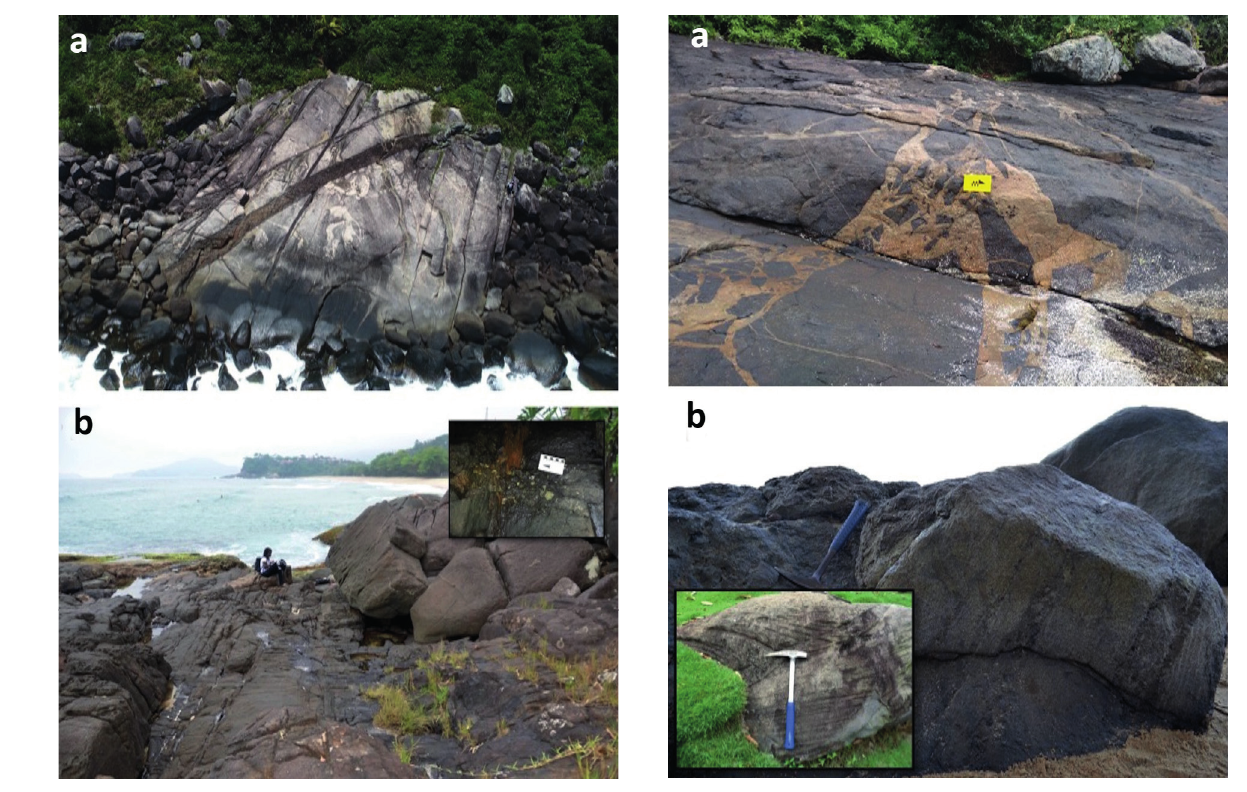
Figure 4 - representative geosites related to the GF Late Cretaceous Alkaline Magmatism. Geosite “Contact relationships between alkaline rocks of Ilhabela”. a ) Syenite and gabbro in the Jabaquara Beach. Photo: M. timich; b ) Magmatic compositional layering in cumulate gabbro in Pacuíba Beach. In the detail, “cross bedding” layering (Photo: F. rodrigues).